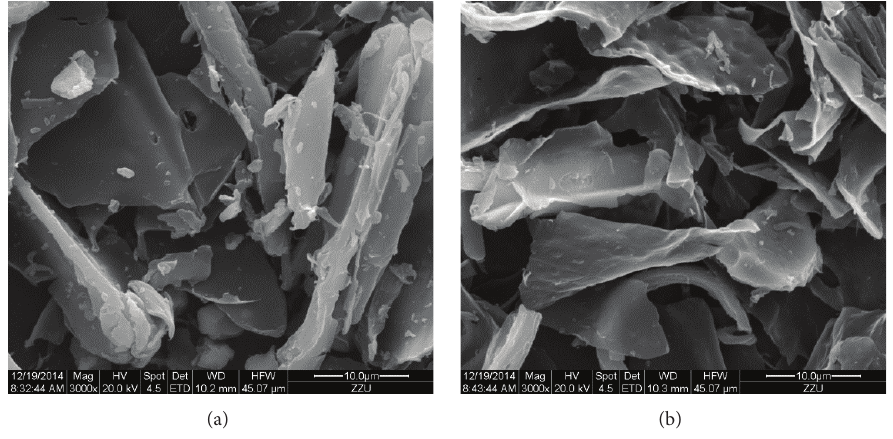
Figure 1: SEM image of raw cornstalk (a) and cornstalk biochar pyrolyzed at 600 ∘ C (b).